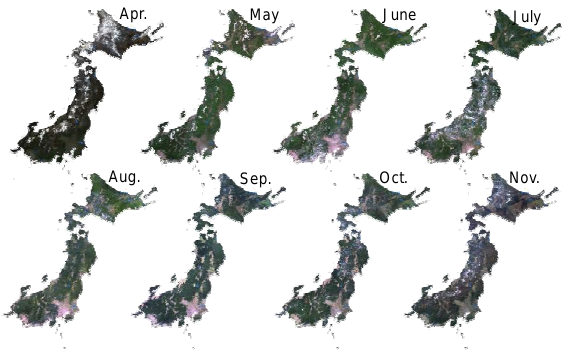
Figure 2. Monthly Composite Images from Terra/MODIS data for